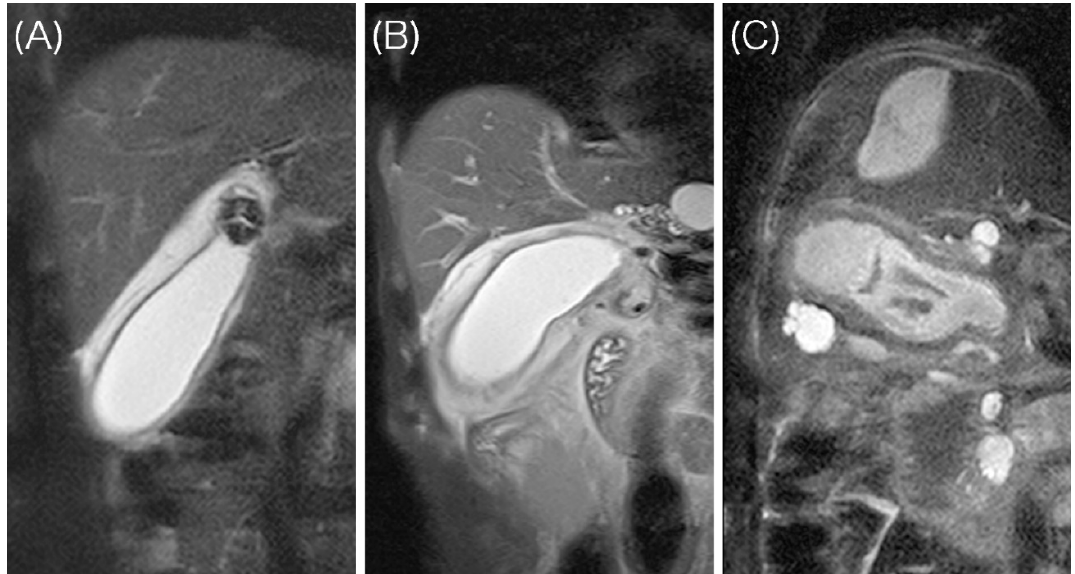
Figure 1. Layered pattern of the gallbladder wall. ( A ) High signal intensity (HSI) type: Thin inner layer with a low signal intensity, thickened outer layer with a high signal intensity, and well-defined margin; ( B ) intermediate signal intensity (ISI) type: Partially thickened inner layer, intermediate signal intensity in the outer layer, and ill-defined margin; ( C ) low signal intensity (LSI) type: Diffusely thickened low signal intensity layer.